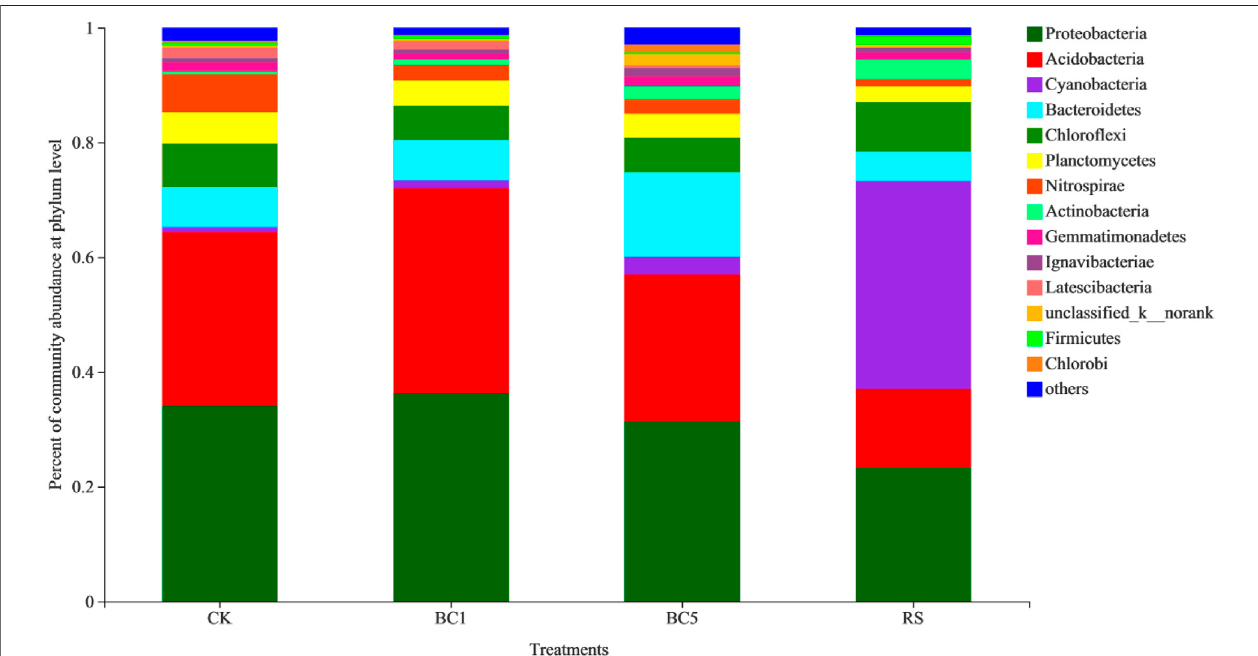
FIGURE 3 | Relative abundance of dominant phyla as affected by the long-term successive biochar and rice straw amendment. CK: without biochar or rice straw; BC1: 2.25 Mgha − 1 biochar; BC5: 11.25 Mgha − 1 biochar; RS: 2.25 Mgha − 1 rice straw.